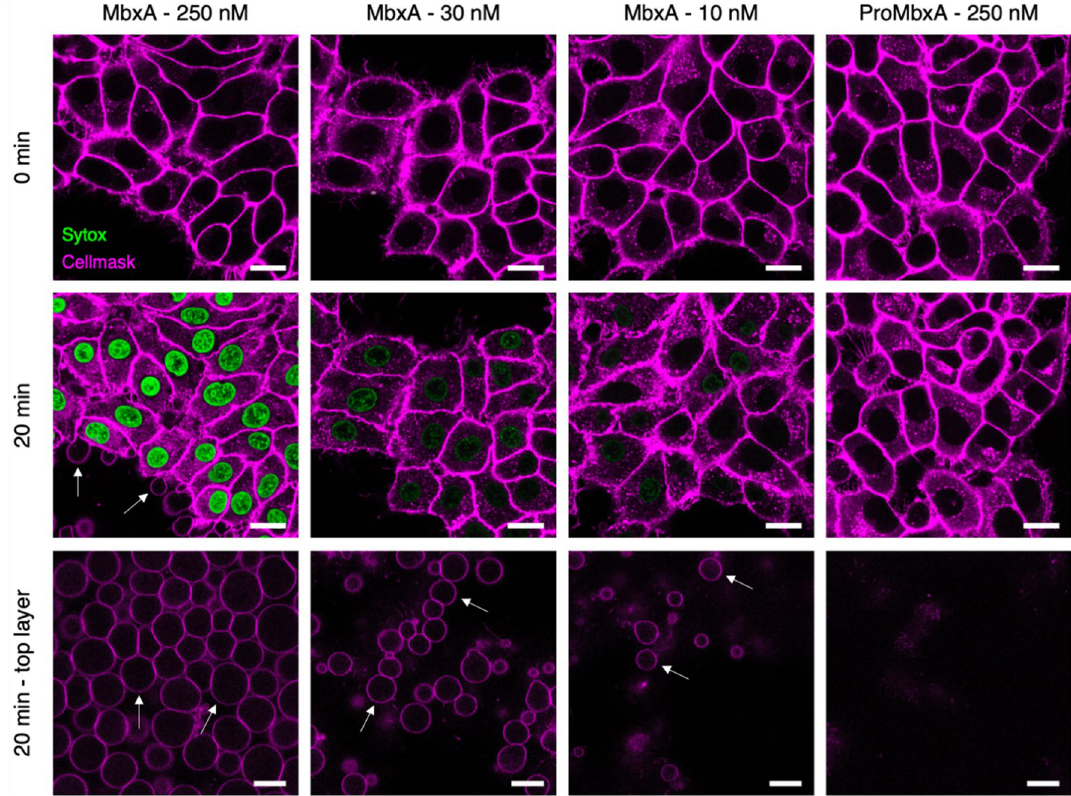
Figure 9. Confocal microscopy images of MbxA-induced membrane permeabilization and membrane blebbing in HEp-2 cells. HEp-2 cells were incubated with MbxA (250 nM, 30 nM and 10 nM at 37 °C) or proMbxA (250 nM) and analyzed at time point zero (first row) and after 20 min (second row). Plasma membrane was stained by CellMask Deep Red and membrane permeabilization was monitored using Sytox Green staining of the nuclear DNA. Incubation of HEp-2 cells with 250 nM, 30 nM and 10 nM MbxA resulted in DNA staining with Sytox Green cells in decreasing intensity corresponding to the decreasing concentration of MbxA and hence in membrane permeabilization. DNA staining was not observed when HEp-2 cells were incubated with 250 nM proMbxA. Membrane blebs were observed in the same focus layer as the HEp-2 cells (second row; white arrows) and above the HEp-2 cells (third row; white arrows). While incubation with 250 nM and 30 nM MbxA led to severe appearance of membrane blebbing, incubation with 10 nM of MbxA was less noticeable and 250 nM proMbxA incubation did not lead to any formation of blebs. Please see Fig. S4 for the entire images. Scale bar: 20